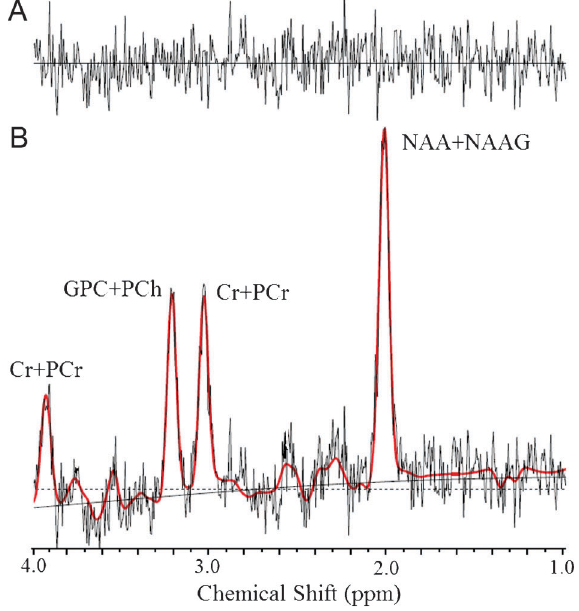
Figure 2. Example spectrum from a healthy subject. A , Residual fit. B , The black noisy line corresponds to the original spectrum while the red line corresponds to the fitted LCModel spectrum. Substance abbreviations are identified in Table 2. baseline (smoother black line) and the fitted spectrum (red line) as calculated by LCModel.